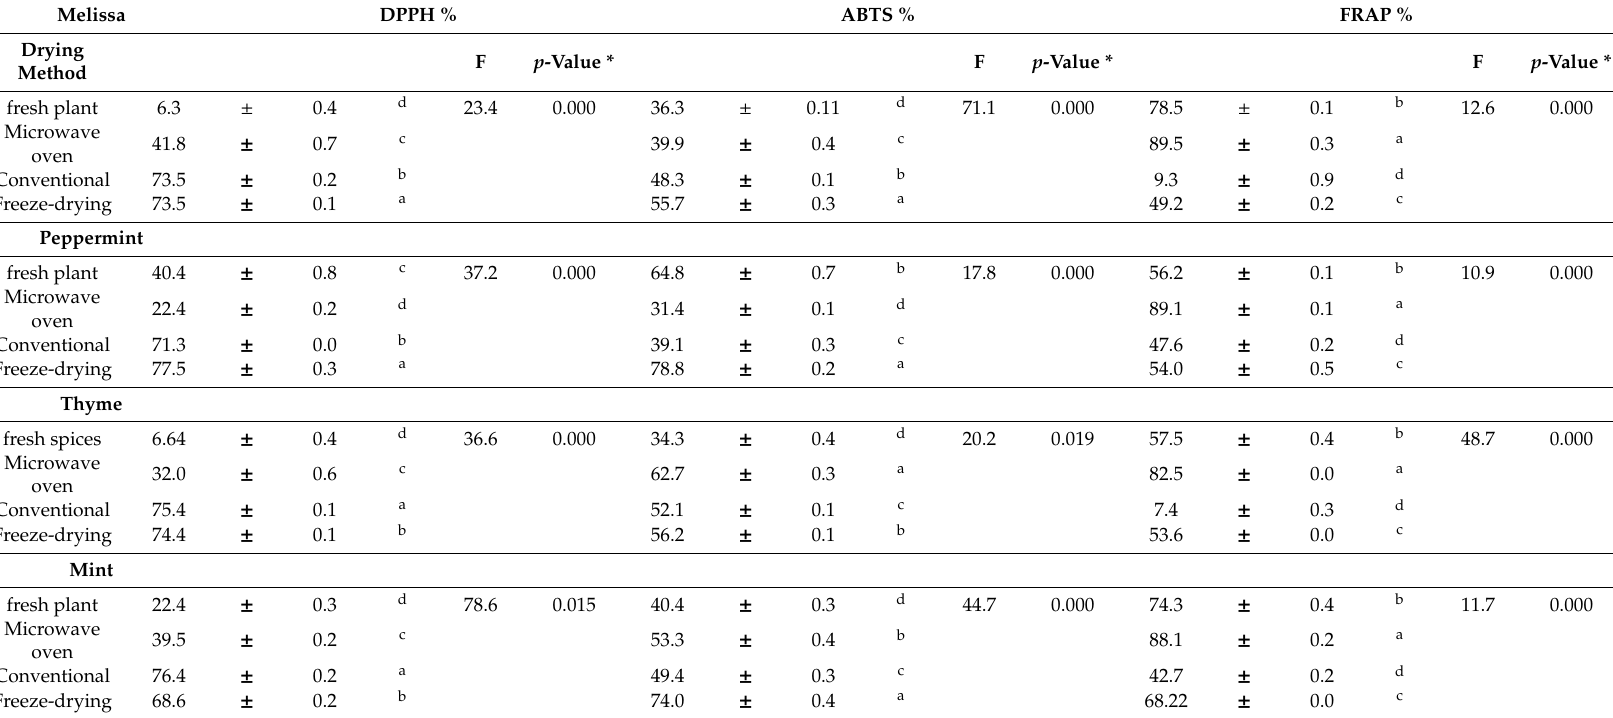
Table 2. Antioxidant capacity of secondary metabolites in methanol extracts in melissa, peppermint, thyme, and mint. Melissa DPPH % Drying